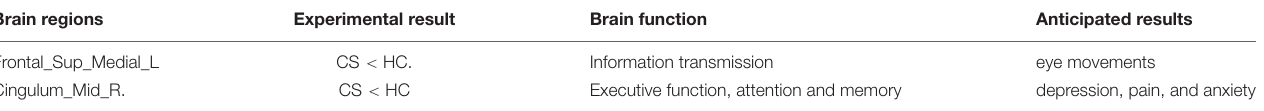
TABLE 4 | Brain regions alternation and its potential impact.